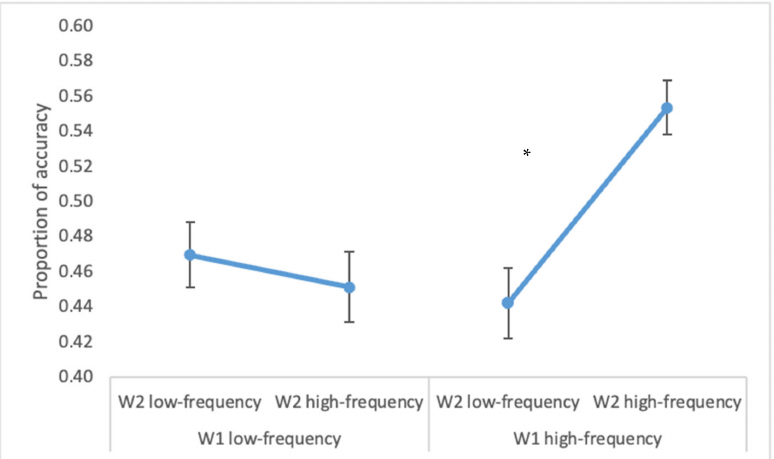
Figure 1. Experiment 1. W2 accuracy in the conditions of W1 and W2 low- and high-frequency. The figure represents the statistically significant interaction W1 frequency × W2 frequency. Bars represent standard errors. The asterisk (*) indicates statistically significant differences.